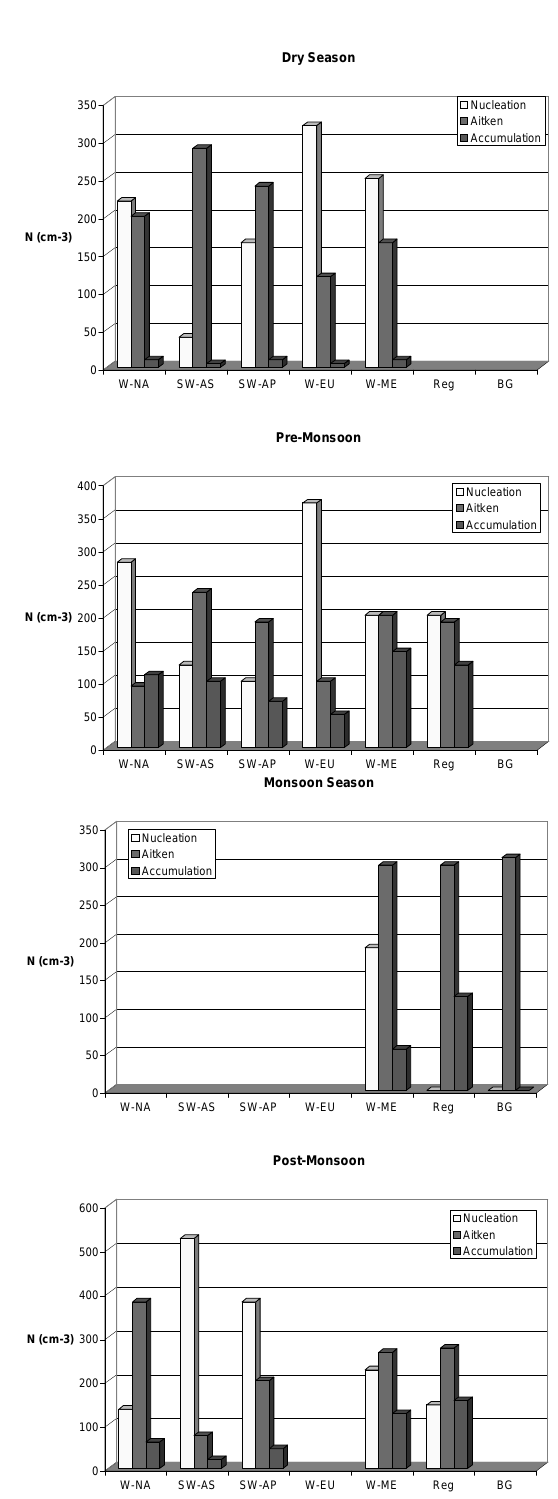
Fig. 4. Contribution of the nucleation, Aitken and accumulation modes integrated number concentrations to the total aerosol num- ber concentration under nighttime conditions for different air mass types for the (a) dry season, (b) pre-monsoon season, (c) monsoon season and (d) post-monsoon